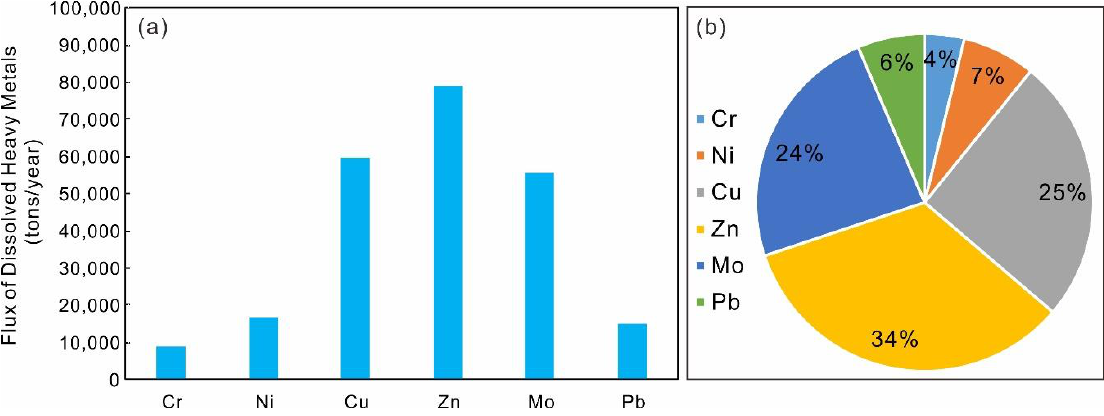
Figure 6. The flux of dissolved heavy metals in the Lancangjiang River: (a) the flux of dissolved heavy metals; (b) the proportion of each dissolved heavy metal flux.